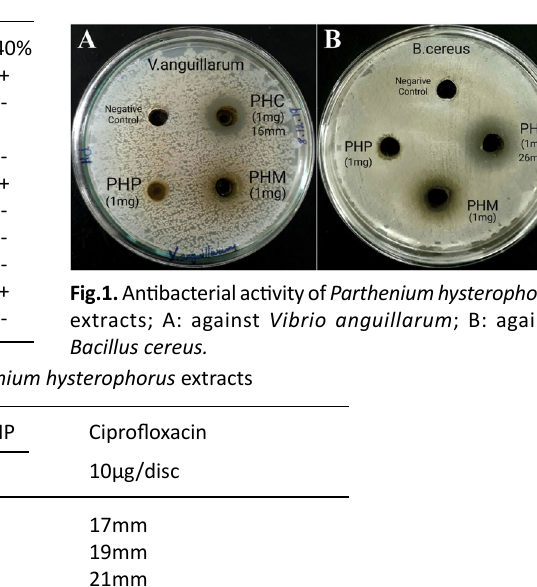
Table 1. Phytochemical screening of crude extracts with yield percentage PHM: Methanol extract; PHC: Chloroform extract; PHP: Petroleum Ether extract Phytochemicals